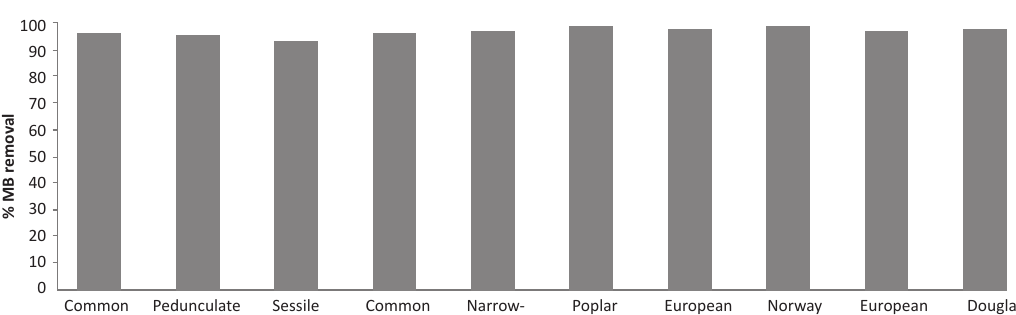
=50 mg·dm -3 , t=120 min, T=298.15 dye